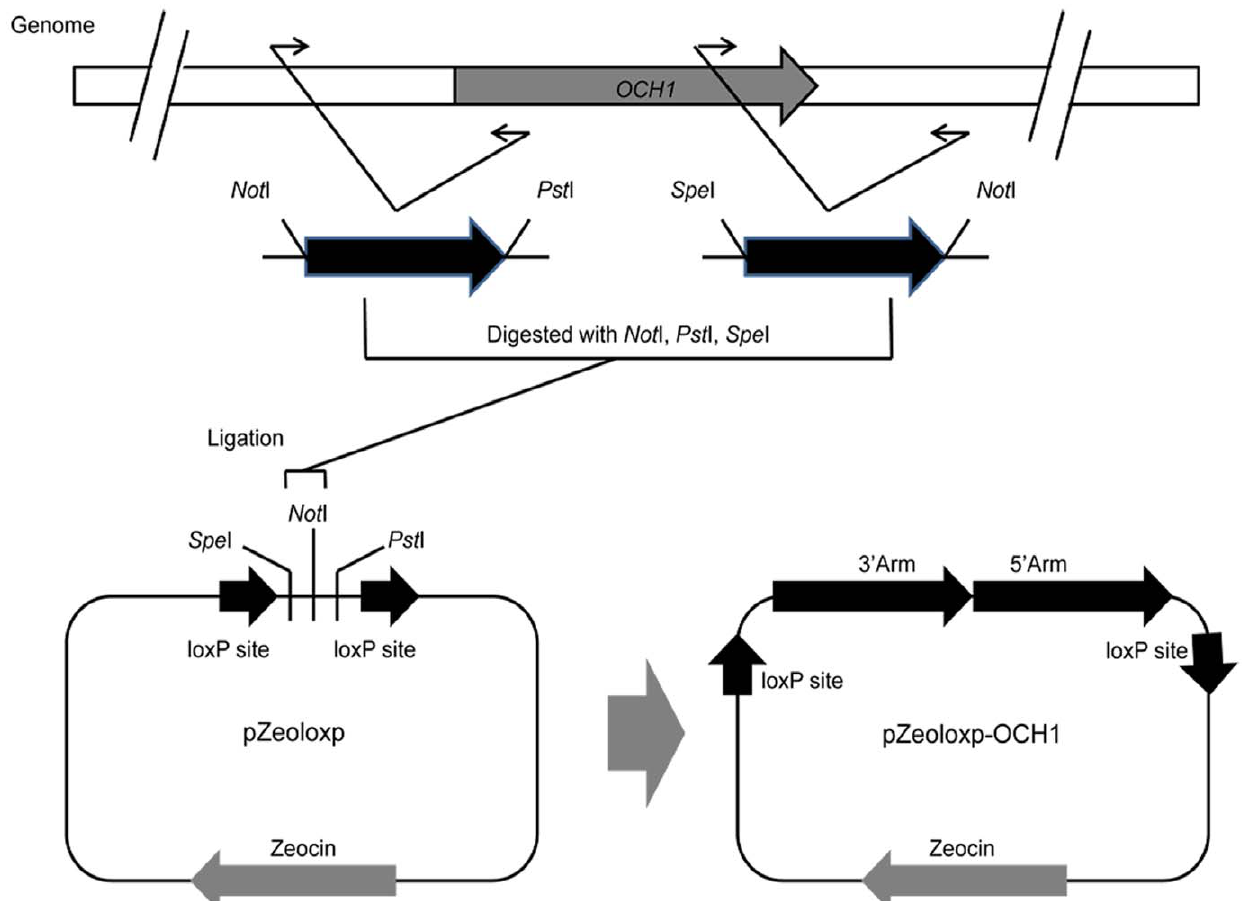
Figure 2. Schematic representation of the construction of the disruption plasmid. The OCH1 gene was used as an illustrative example. Upstream and downstream homologous regions of OCH1 were initially amplified by polymerase chain reaction from Pichia pastoris GS115 strain with two primer pairs. The two fragments were cut using Spe I, Not I, and Pst I, as well as ligated into pZeoloxp by performing a three-fragment ligation, thereby generating pZeoloxp-OCH1, which is the disruption plasmid for the OCH1